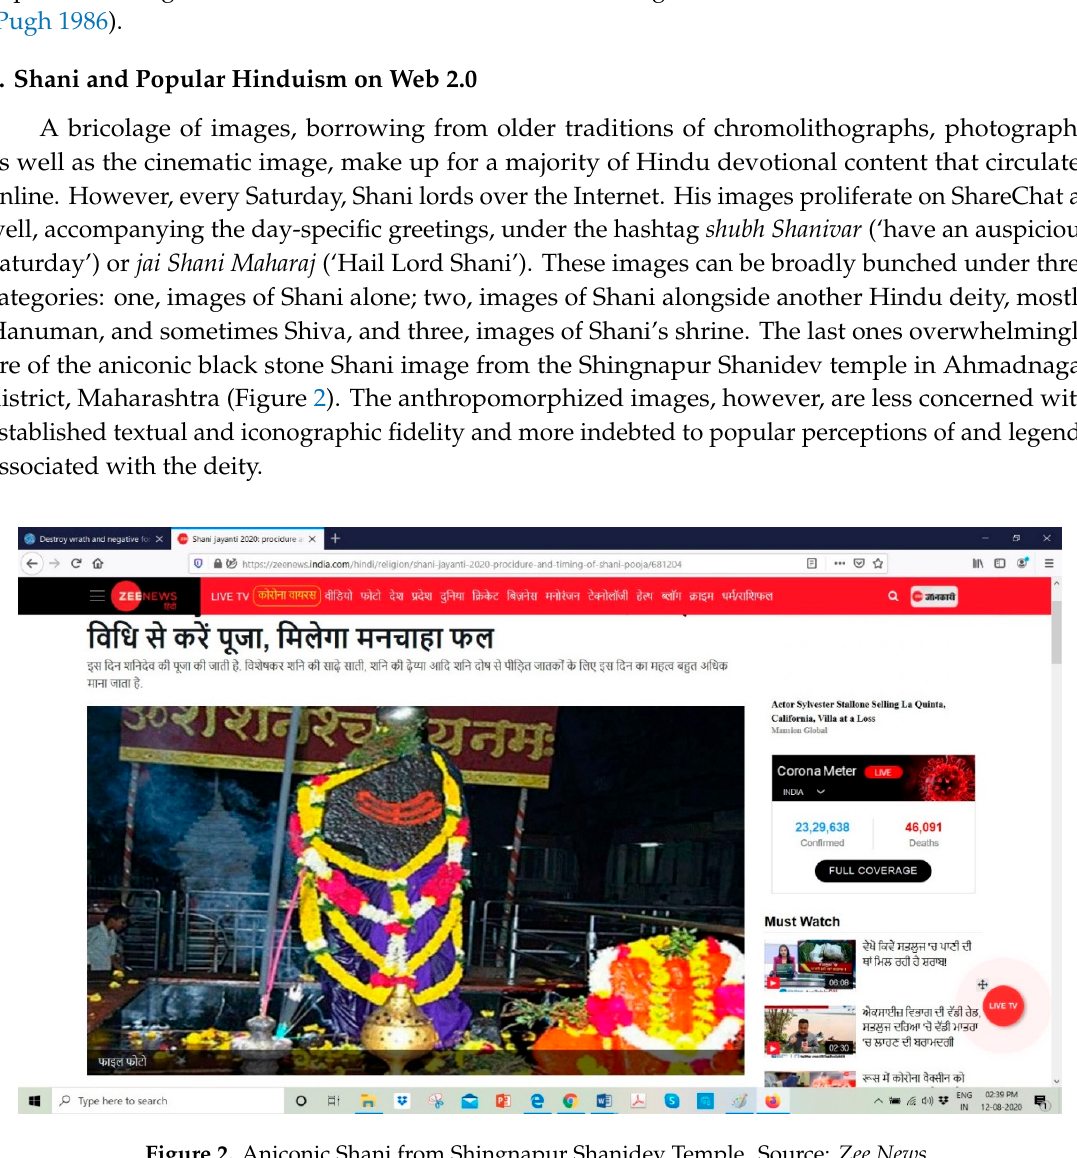
Figure 3. Shani riding the crow. Source: Jagaran.